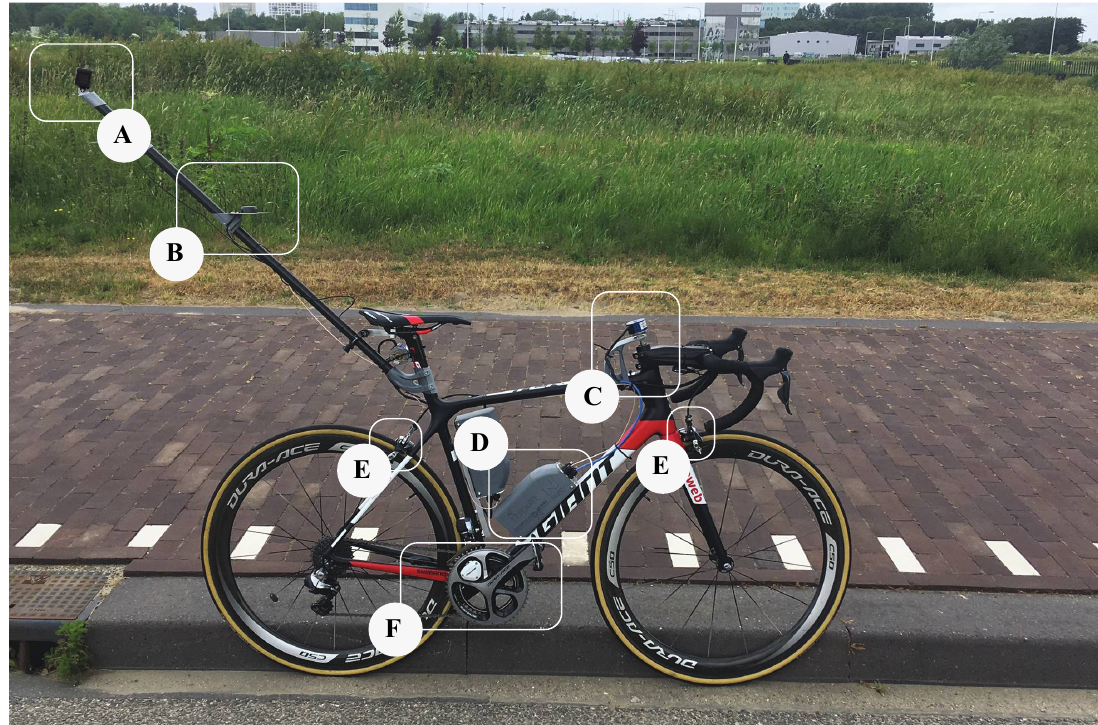
Figure 1. Measurement system installed on a bicycle. ( A ) GoPro camera and mount to record rider posture; ( B ) GNSS antenna to measure rider’s position on the road; ( C ) optical encoder to measure steering angle; ( D ) IMU to measure roll angle and data acquisition system; ( E ) strain gauges on brake shoe to measure brake force; ( F ) velocity sensor and power